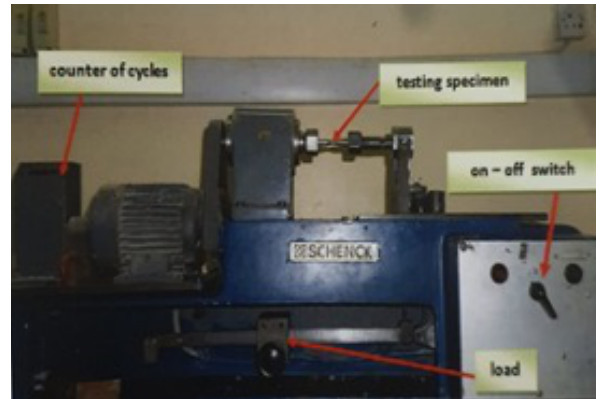
Figure 4: Fatigue testing